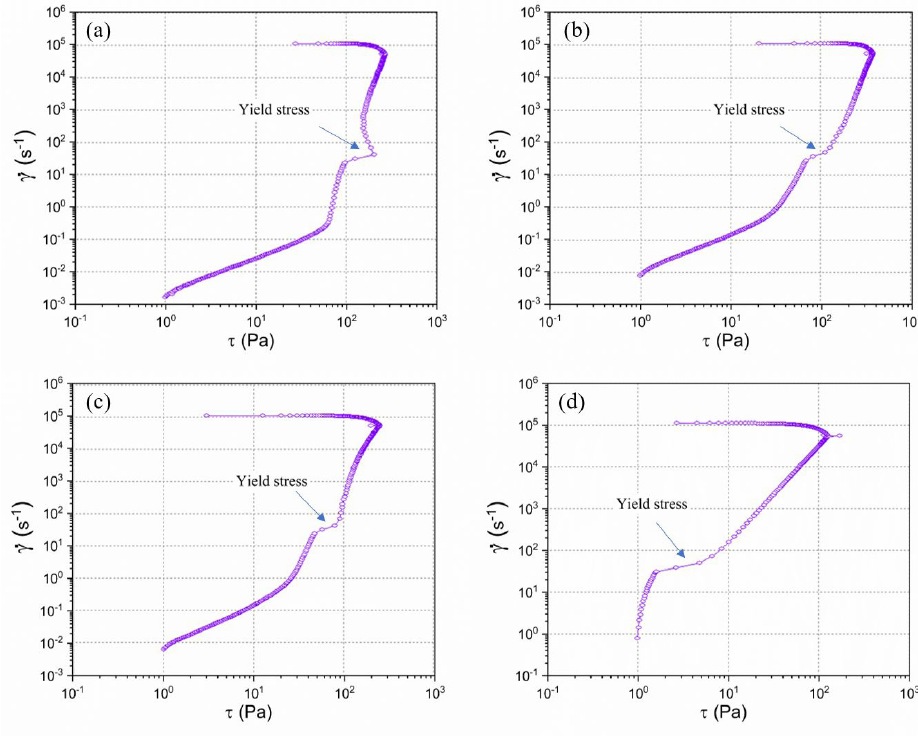
Figure 2. Curves showing the yield stress (shear rate versus shear stress) for the samples (a) 2A, (b) 3E, (c) 7SA and (d) 10NA.